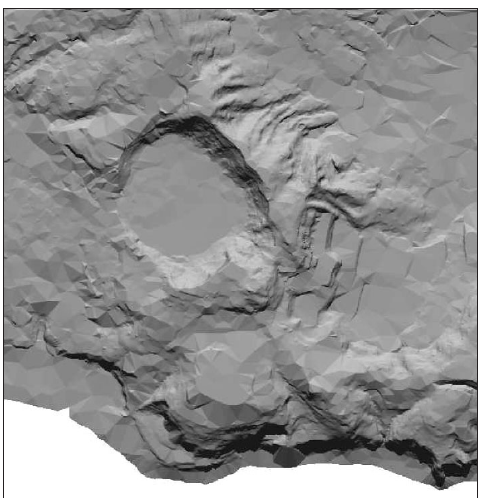
Fig. 2. Shaded relief of the zone surrounding the Solfatara crater. The maximum height in the domain is about 203 m a.s.l. The resolution of the used topogra- phy model in our discretization was 50 m × 50 m.